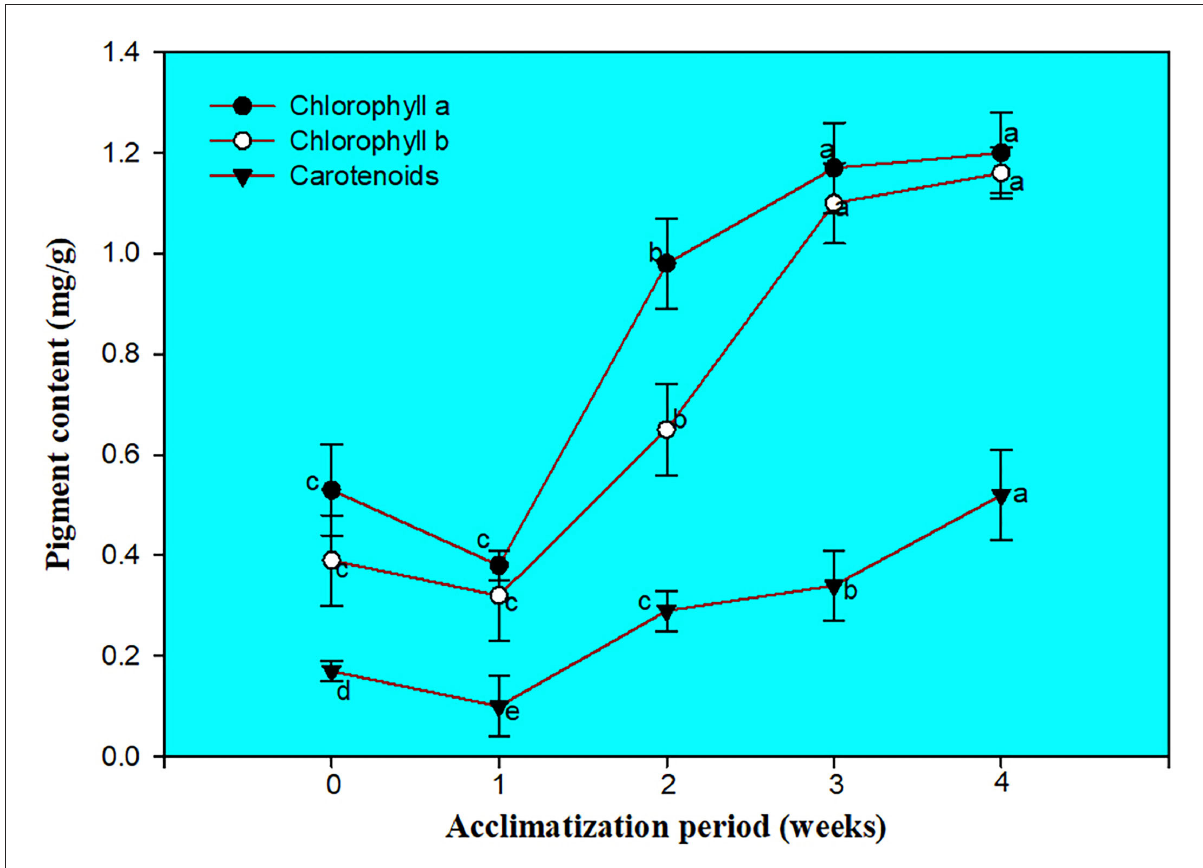
FIGURE3 Changes in chlorophyll a and b and carotenoid contents (Mean ±